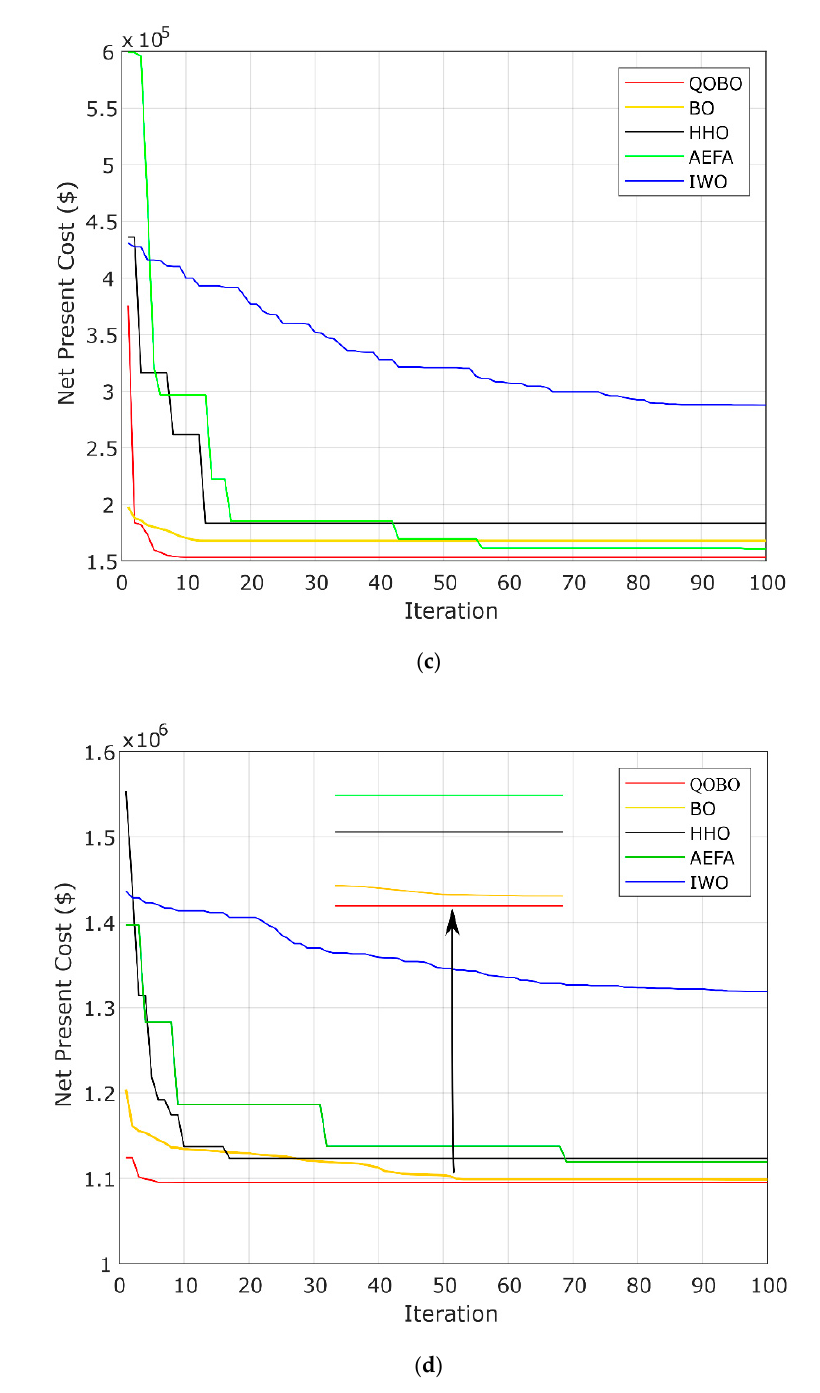
Figure 10. Convergence of the objective function of all algorithms for different scenarios; ( a ) PV/WT/Diesel/BESS, ( b ) PV/Biomass, ( c ) PV/Diesel/BESS, ( d ) WT/Diesel/BESS.